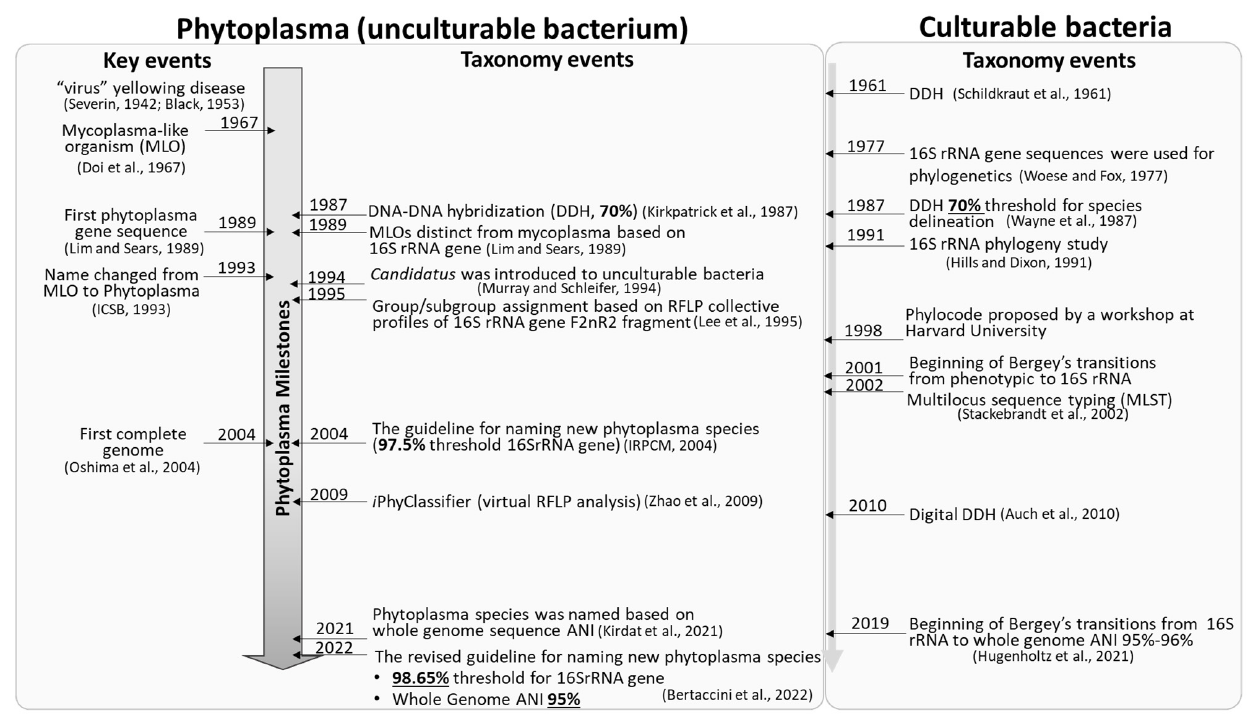
Figure 1. Key events of phytoplasmas and milestones of phytoplasma taxonomy . Details please see